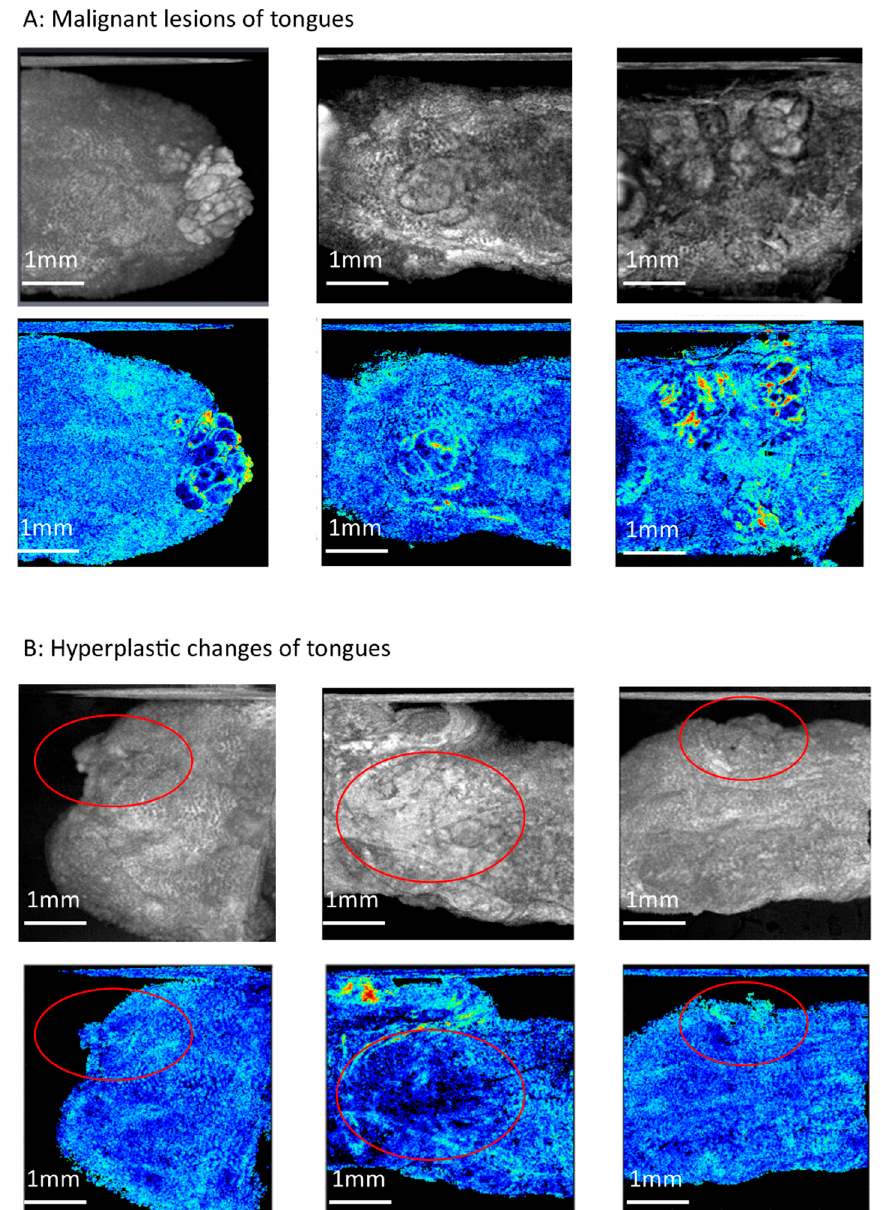
Figure 5. Compare en-face intensity images to the en-face birefringence maps. ( A ) Malignant lesions of tongues. The tumor can be seen clearly in these two en-face images ( B ) Hyperplastic changes of tongues. In en-face intensity images (upper pictures), the heterogeneous area was seen (circle area), which mimic the tumor. In corresponding en-face birefringence maps, the distribution of bright spots in the circle area without significant demarcation lines indicates hyperplastic change without a tumor.